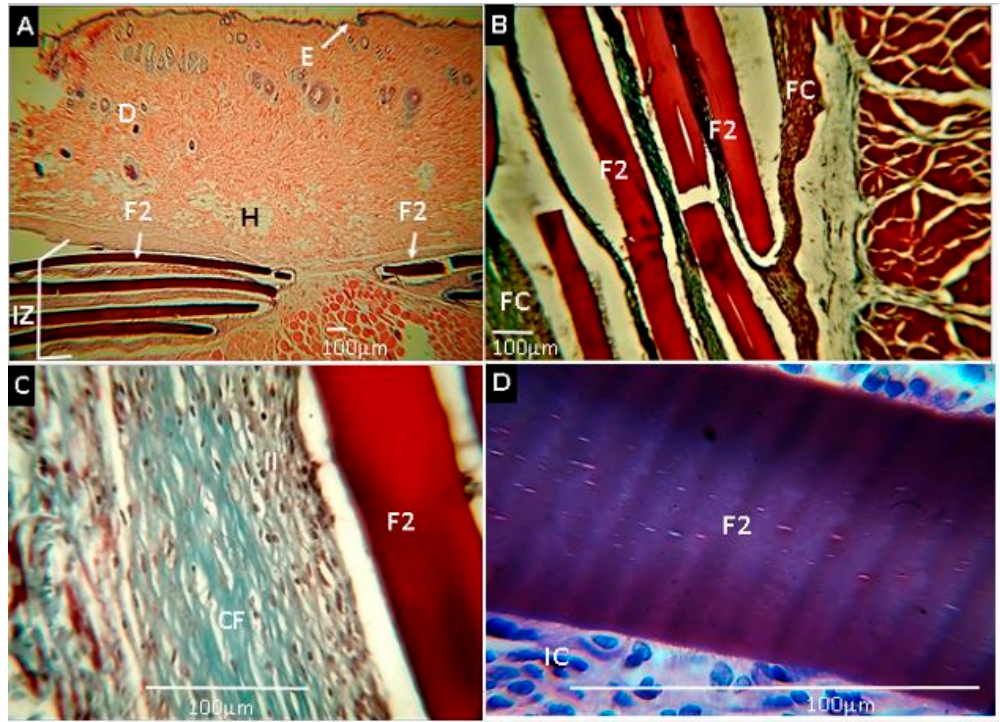
Figure 12. Histological analysis of experimental sample F2 (CS:PVA:ox-CNO 29.50:70.00:0.50). Magnifications are as follows: ( A ) 4× H&E, ( B ) 10× H&E, ( C ) 40× MT, ( D ) 100× MT. E: epidermis. D: